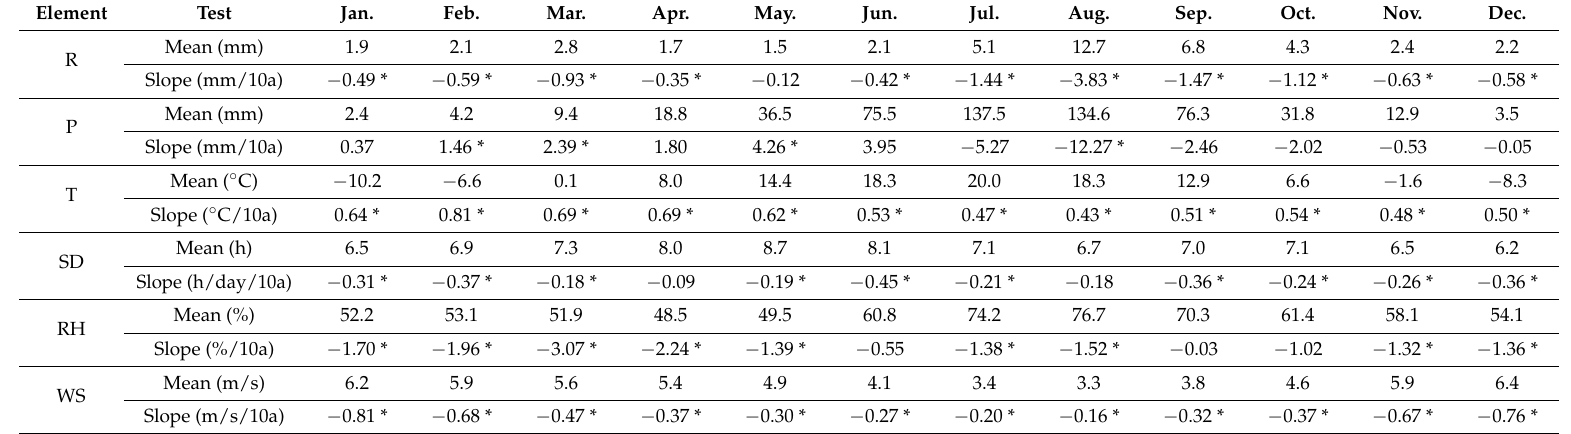
Table 3. The mean value and Mann-Kendall test results of the monthly R and climatic elements in the HTRB during 1956–2015. Element